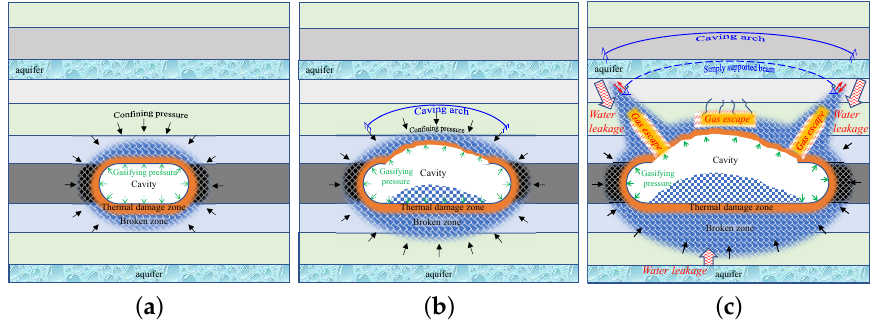
Figure 4. Mechanism of the confining rock breakage during cavity broken and potential risks. ( a ) Small-scale cavity; ( b ) Middle-scale cavity and ( c ) Large-scale